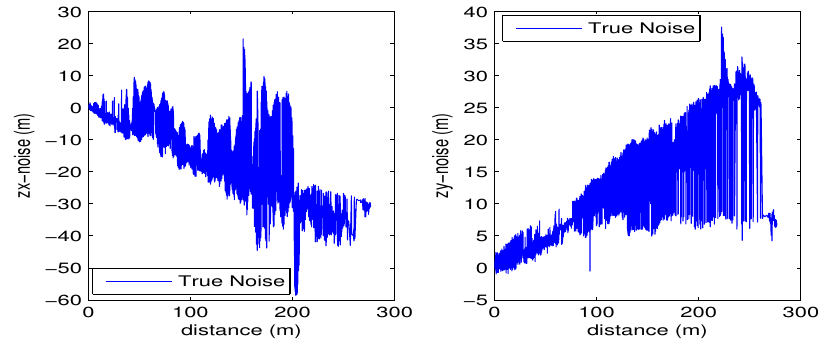
Figure 8. The true measurement error data between IMU and acoustic